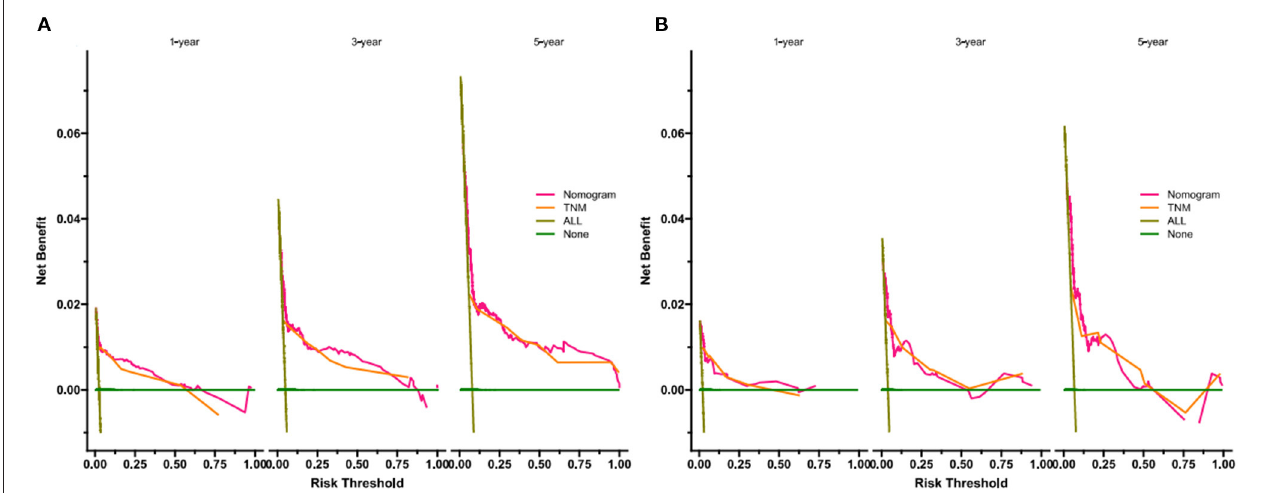
FIGURE 5 | DCA of the nomogram in training cohort (A) and validation cohort (B) . The Y-axis represents a net benefit and the X-axis represents threshold probability. The green line means no patients died and the dark green line means all patients died. When the threshold probability is between 20 and 100%, the net benefit of the model exceeds all deaths or none.